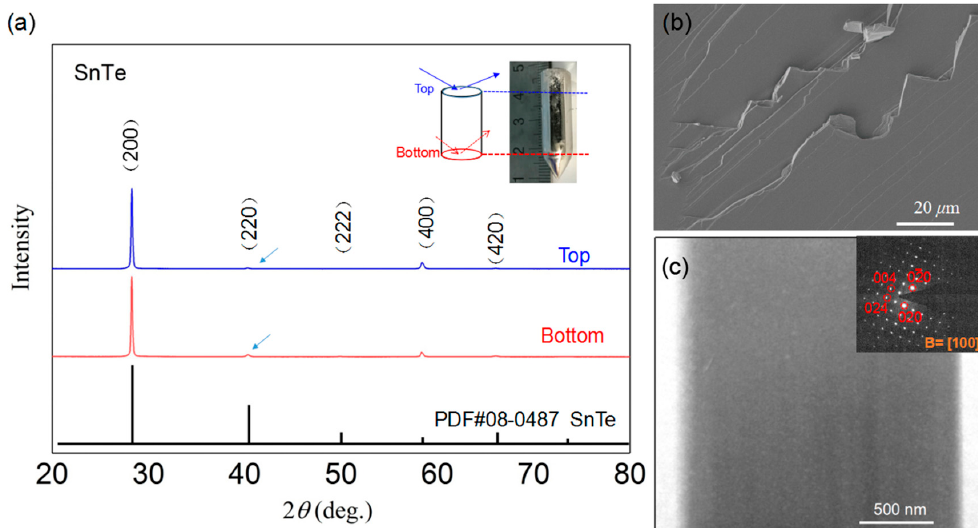
Figure 1. ( a ) XRD patterns of SnTe quasi crystal for both bottom and top planes, perpendicular to the growing direction. The inset figure shows a picture of the sample and a schematic diagram of the measurement directions; ( b ) field emission scanning electron microscopy (FESEM) images for fracture surface structure of SnTe quasi crystal; ( c ) [100] zone-axis low magnification TEM image with inserted fast Fourier transformation (FFT) patterns.